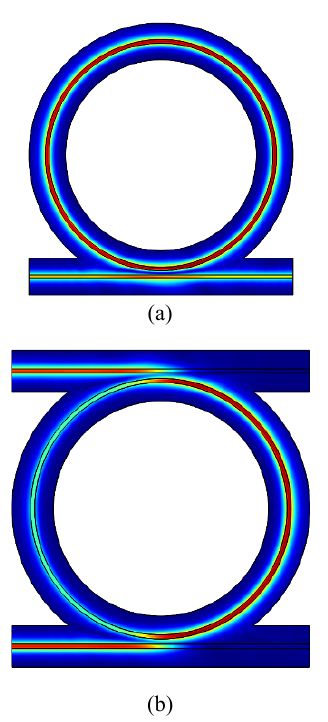
Fig. 1 Two basic configurations of an optical micro-ring resonator: (a) a linear waveguide is coupled to a circular one, and (b) two linear waveguides are coupled to each other through a circular